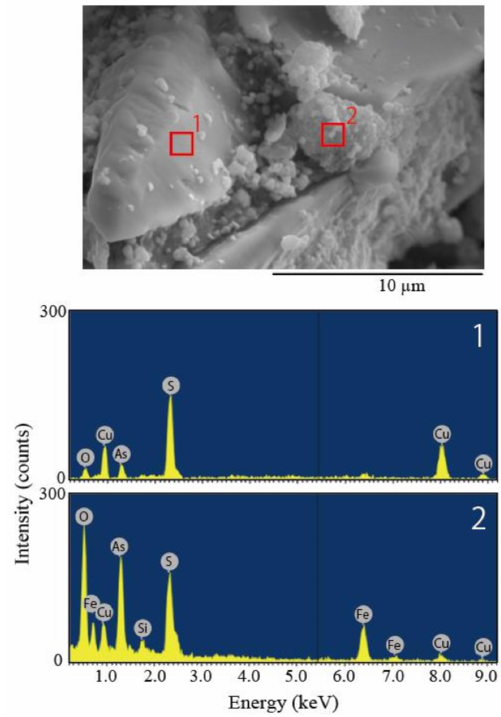
Figure 5. Secondary electron (SE) image and EDS analysis (Oxford Ins. X-act; 15 kV, 5 nA, area analysis mode) of the DC-I residue bioleached for 60 days (without AC).